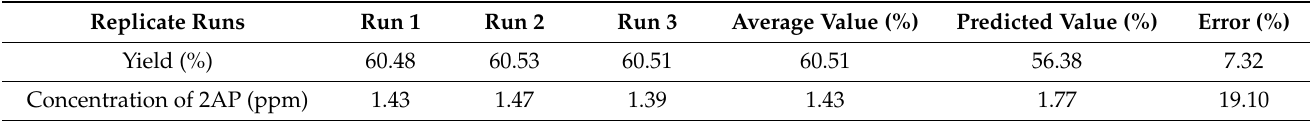
Table 5. Replicate runs at the optimum condition of yield of pandan extract from ultrasonic extraction